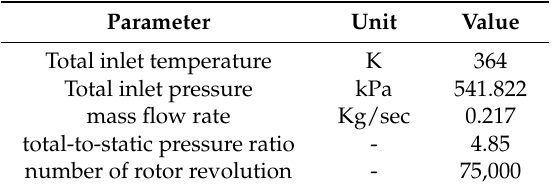
Table 1. Input parameters to design the RI turbine for the